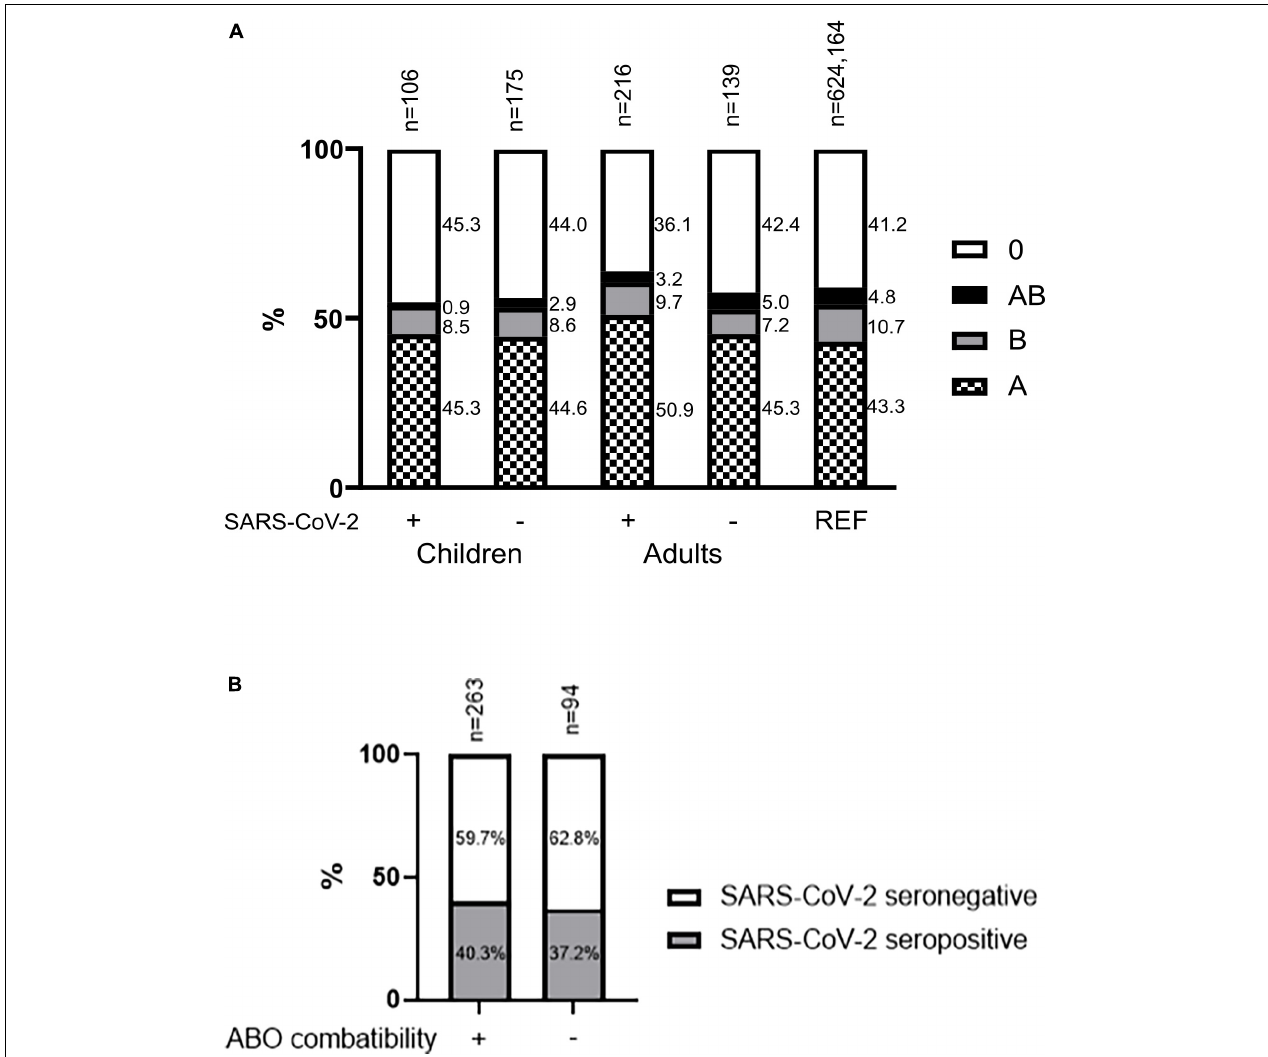
FIGURE 1 | Overall observed blood group type distribution in children and adults (A) and frequency of SARS-CoV-2 transmission from index case to exposed individuals ( n = 357) within the household cohort according to ABO blood group compatibility (B) . (A) Blood group prevalence in child and adult household members and in a German reference population (20). Numbers next to the columns represent the proportion of the particular blood group within the subject group (in percent). Rh, rhesus factor. (B) The black bar indicates the proportion of SARS-CoV-2 seropositive individuals, and the white bar indicates the proportion of SARS-CoV-2 seronegative